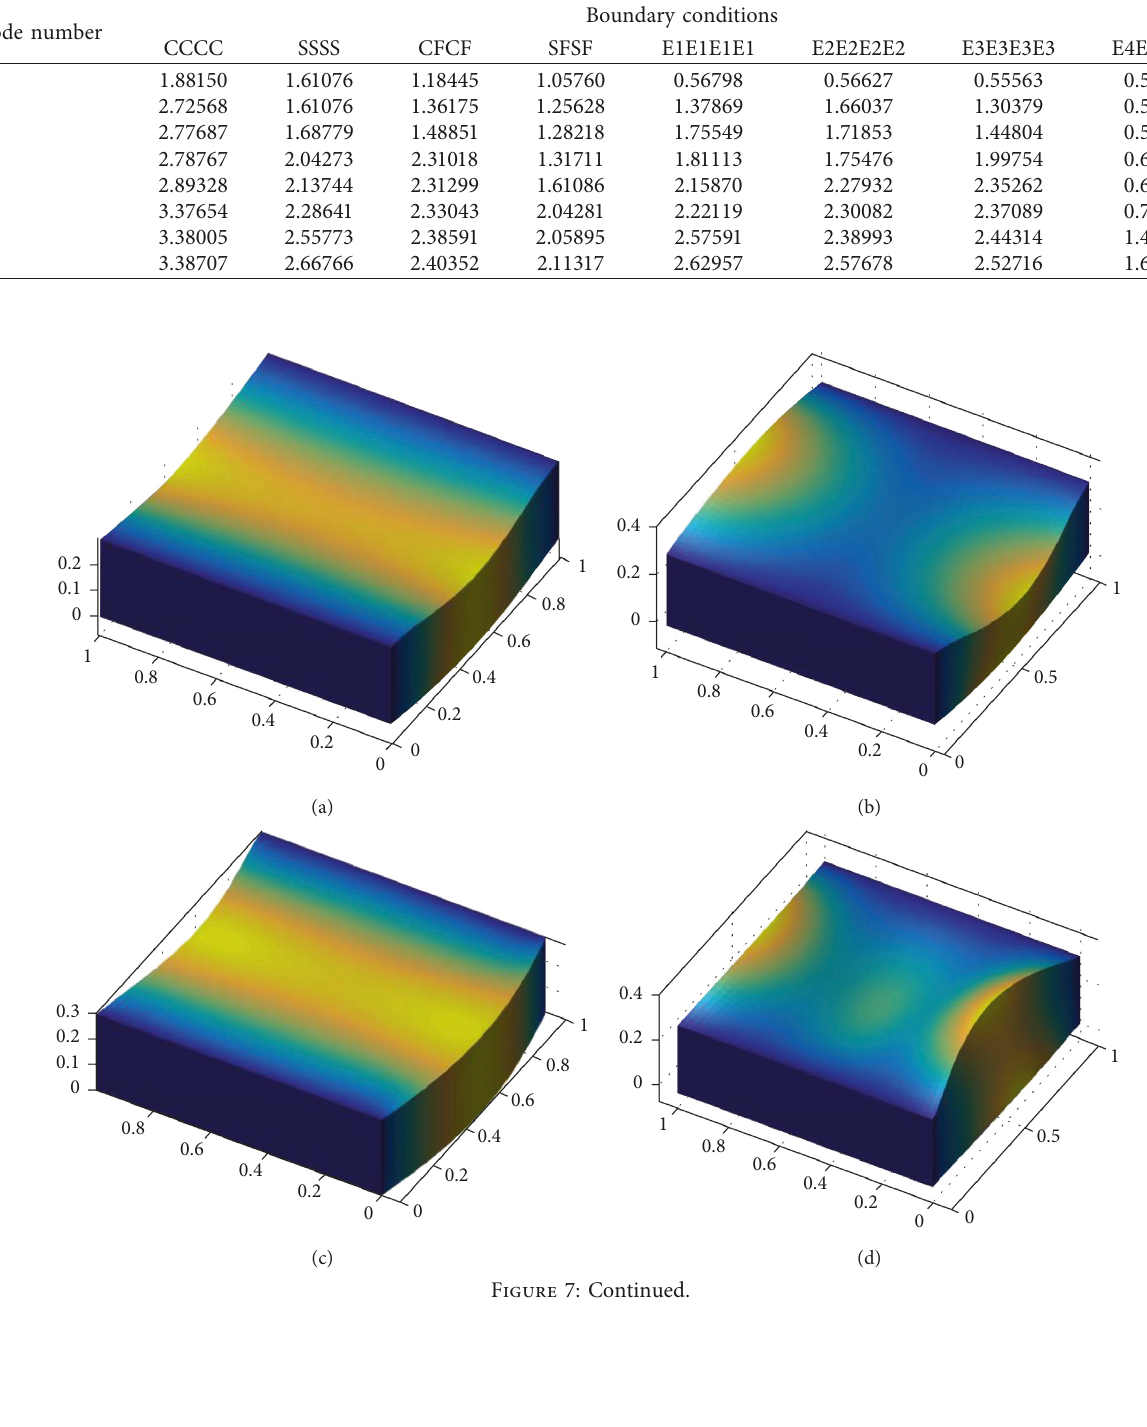
Table 10: First eight frequency